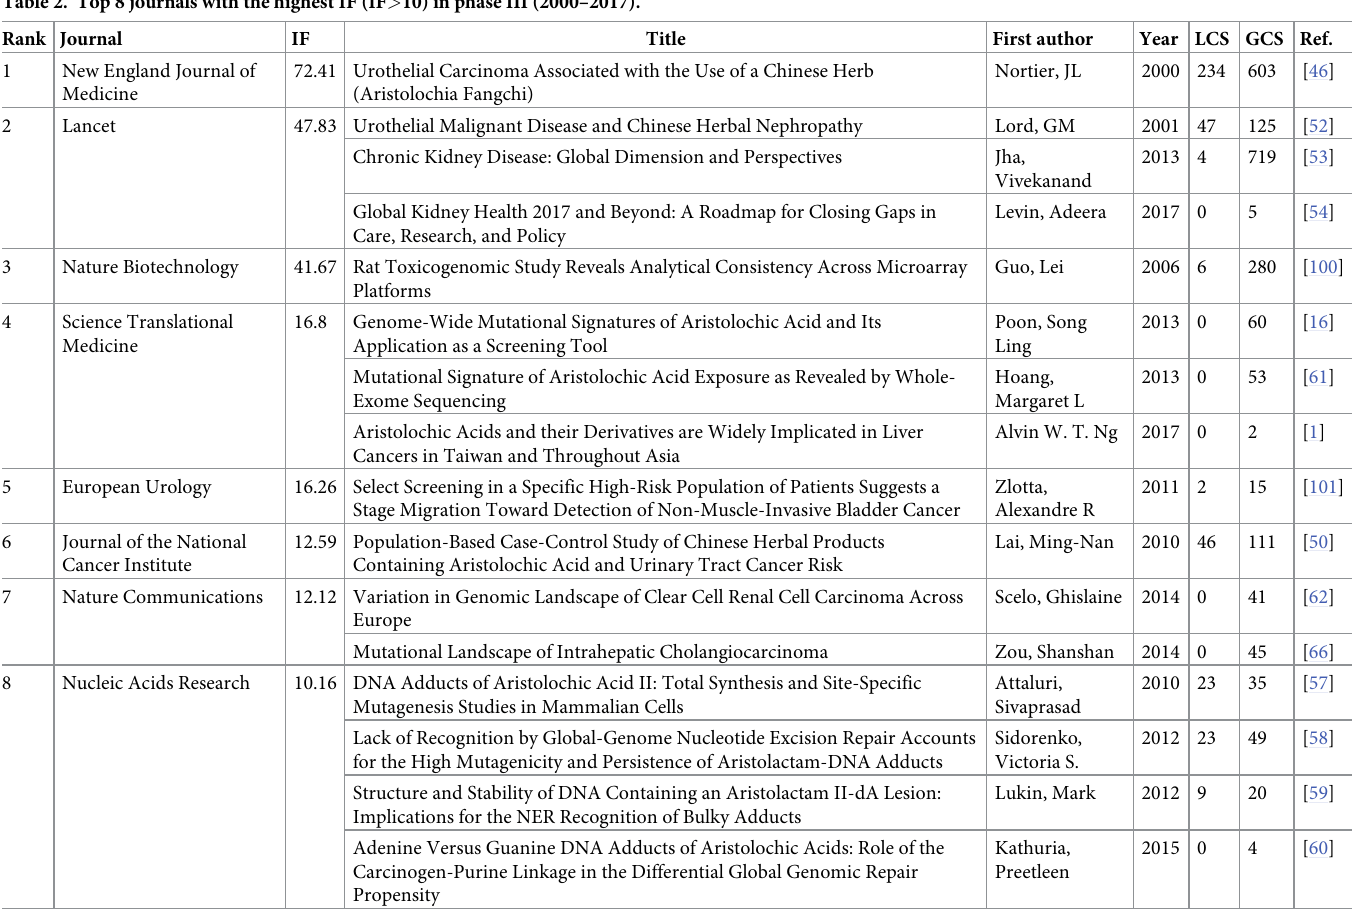
Table 2. Top 8 journals with the highest IF (IF > 10) in phase III